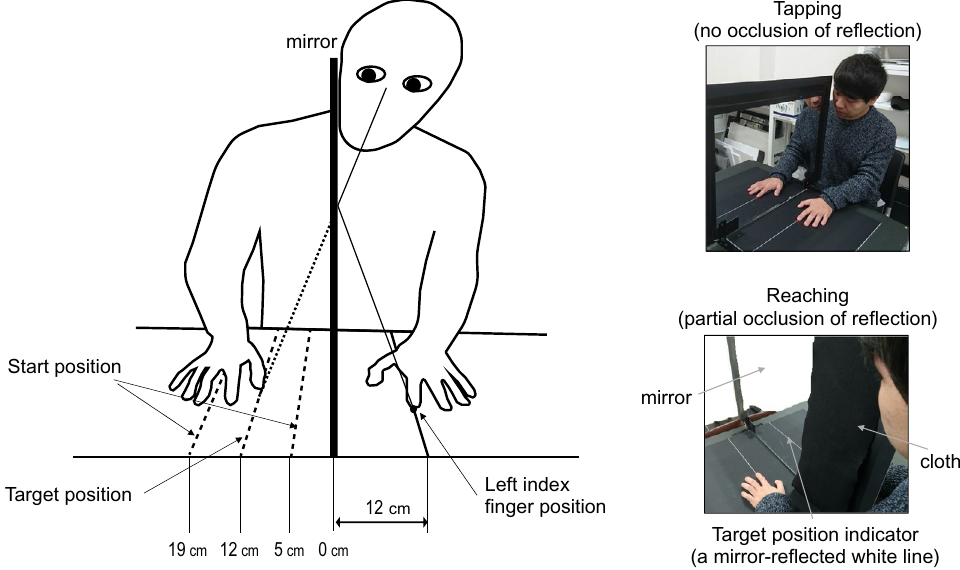
Figure 1. An experimental setup for the mirror hand condition. A mirror was positioned vertically in the middle of a table, with its reflective surface facing the participant’s left. The participant’s left hand was placed at 12 cm left from the mirror where a small red sticker was placed. Participants were asked to synchronously tap both index fingers while viewing the mirror-reflected hand to induce the mirror illusion (upper right panel). The start position of reaching by the unseen, right hand was 19 cm to the right of the mirror for the immediate and delay conditions, and either 5 cm or 19 cm to the right of the mirror for the baseline condition. During reaching, participants were asked to reach the target line (12 cm right from the mirror) indicated in the mirror, which was actually the mirror-reflection of a line drawn 12 cm left from the mirror (bottom right panel). Note that the mirror-reflection of the left hand was occluded by a small cloth during